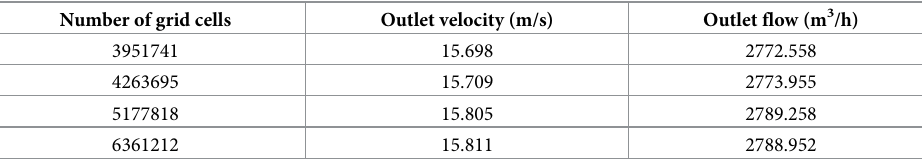
Table 1. Fluid grid independence test data.